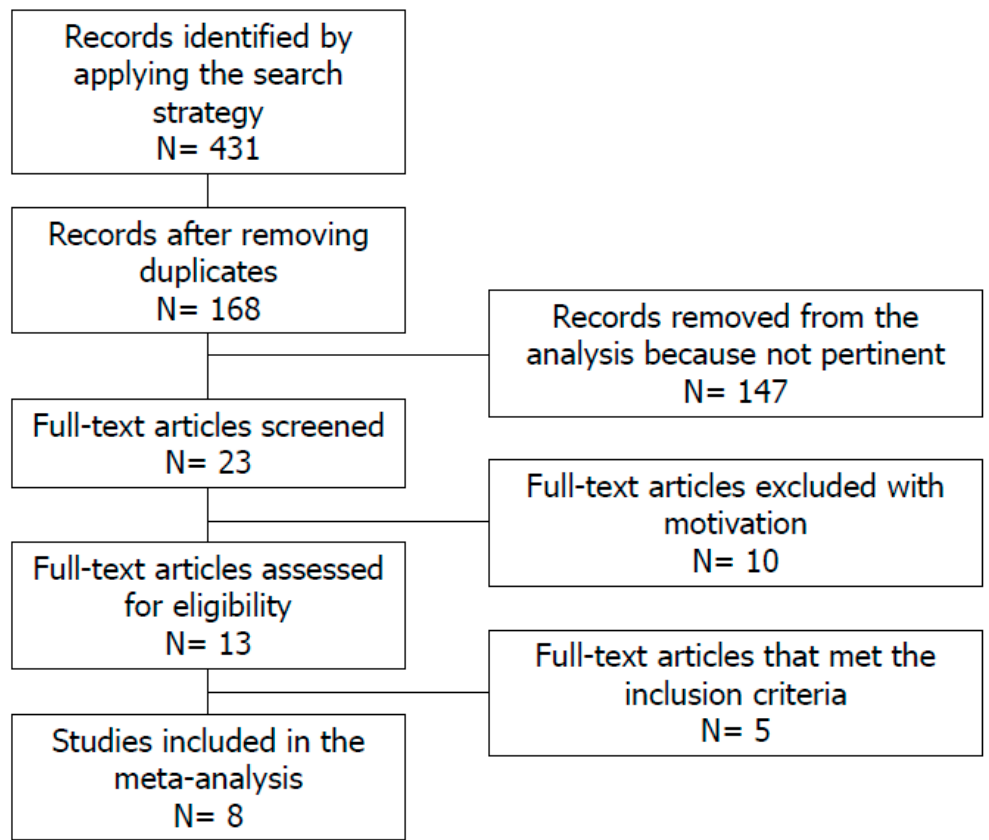
Figure 1. Flowchart of the studies included in the meta-analysis.